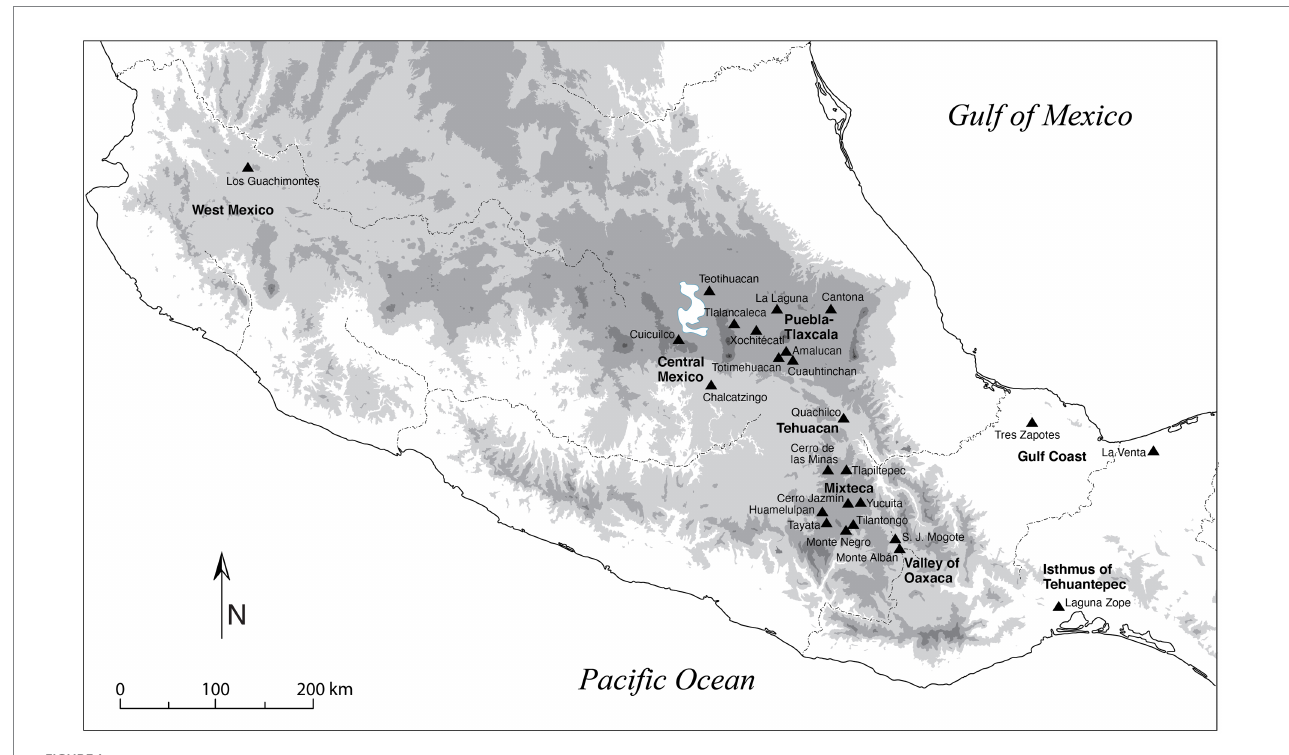
FIGURE 1 Western Mesoamerica, showing central places mentioned in the